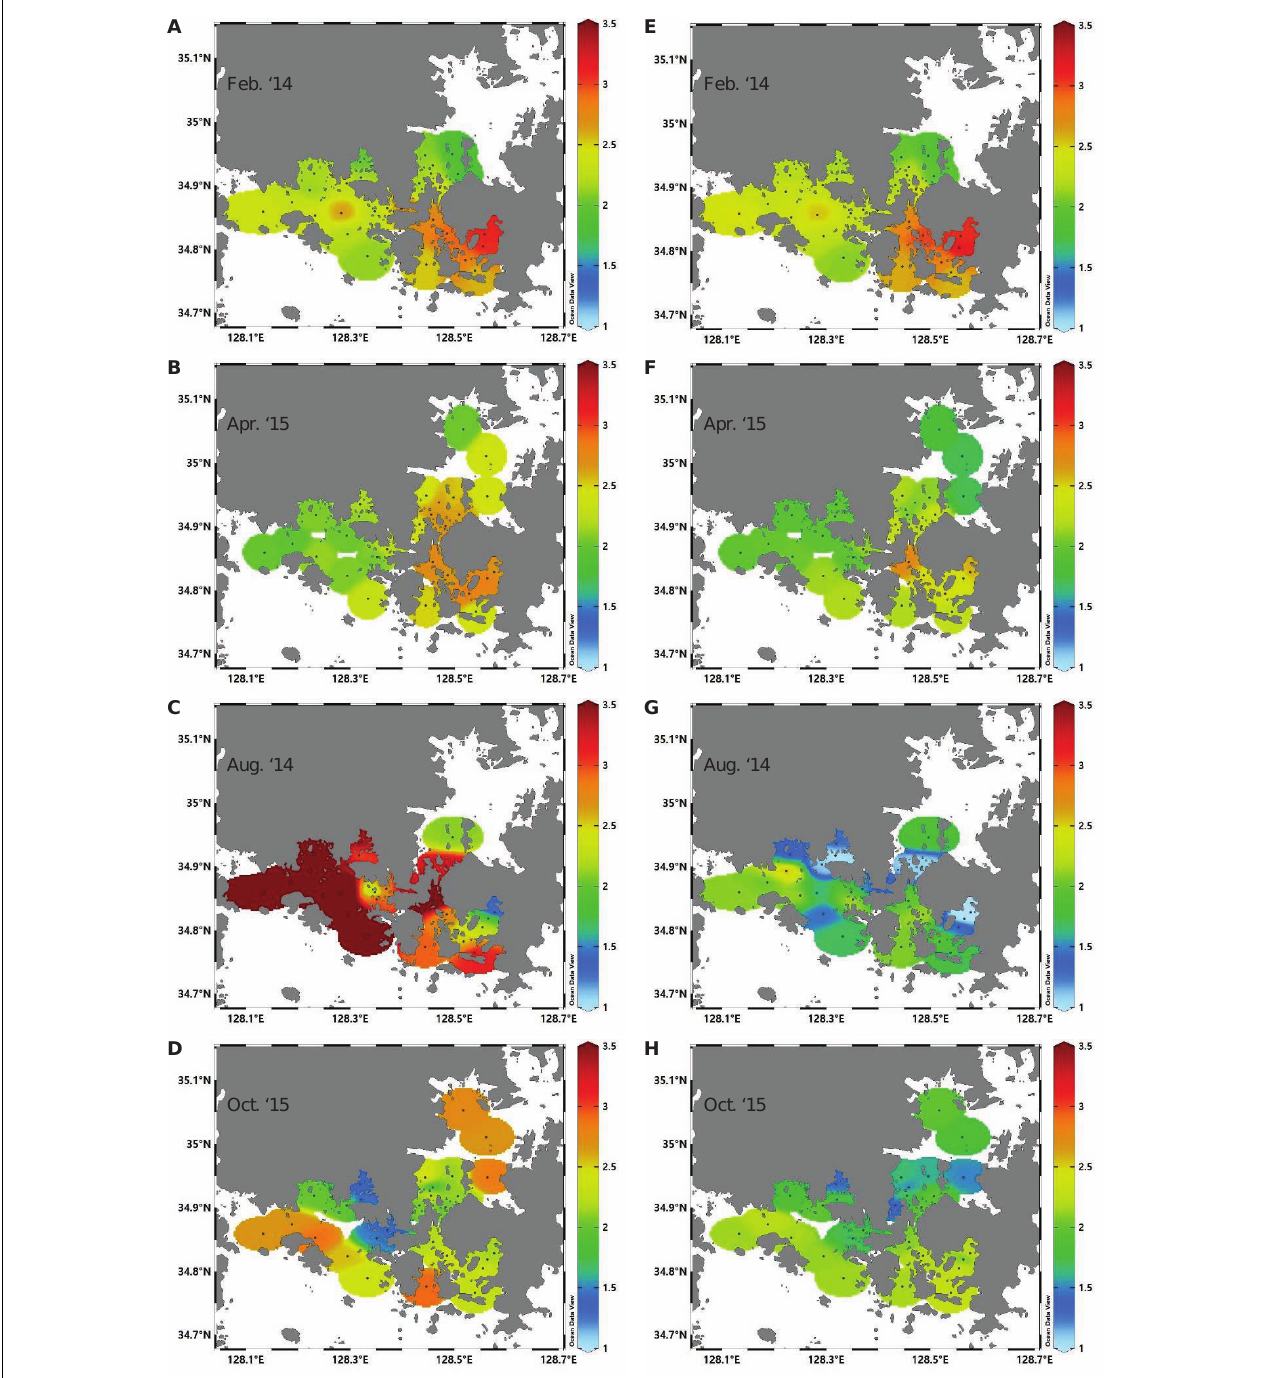
FIGURE 6 | Distributions of aragonite saturation state ( (cid:127) Ar ) in surface water (A–D) and bottom water (E–H) for each survey. The dark red area in panel (C) had values of more than 3.5, hence the overrun in the same scale bar was applied in all figures for